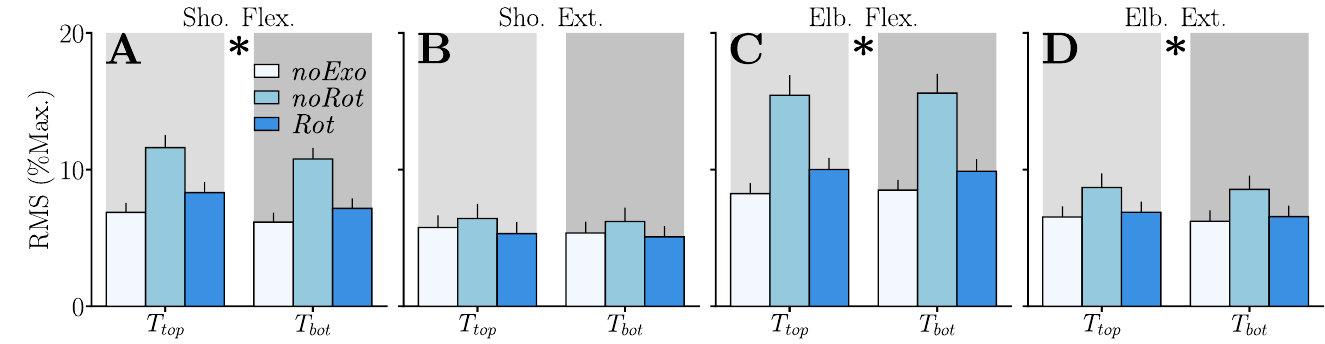
Figure 5. Average RMS of muscle groups for both targets and each condition. A main effect of the condition on the RMS is signaled by “ ∗ ”. All significant ANOVAs returned p < 0.05. ( A )